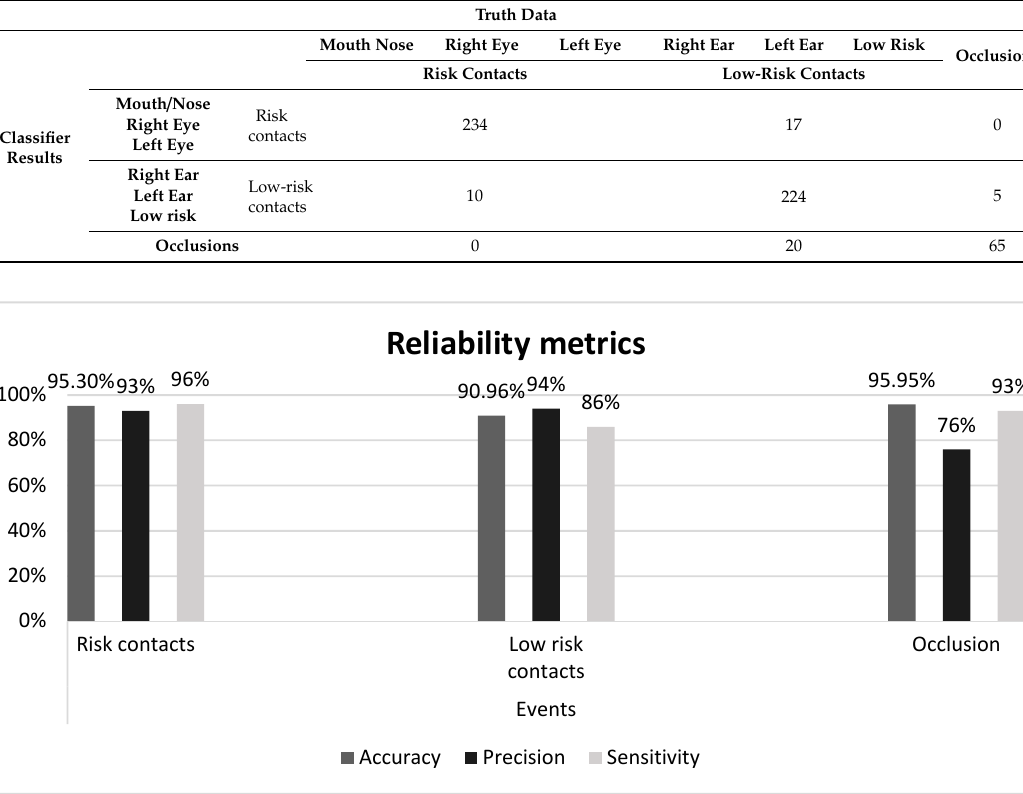
Figure 8. The reliability metrics assessed for each class of the three-class classification.